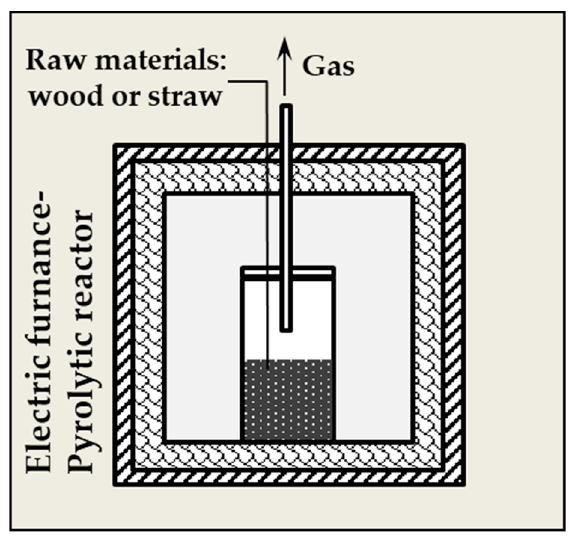
Figure 2. Scheme of the pyrolysis reactor.